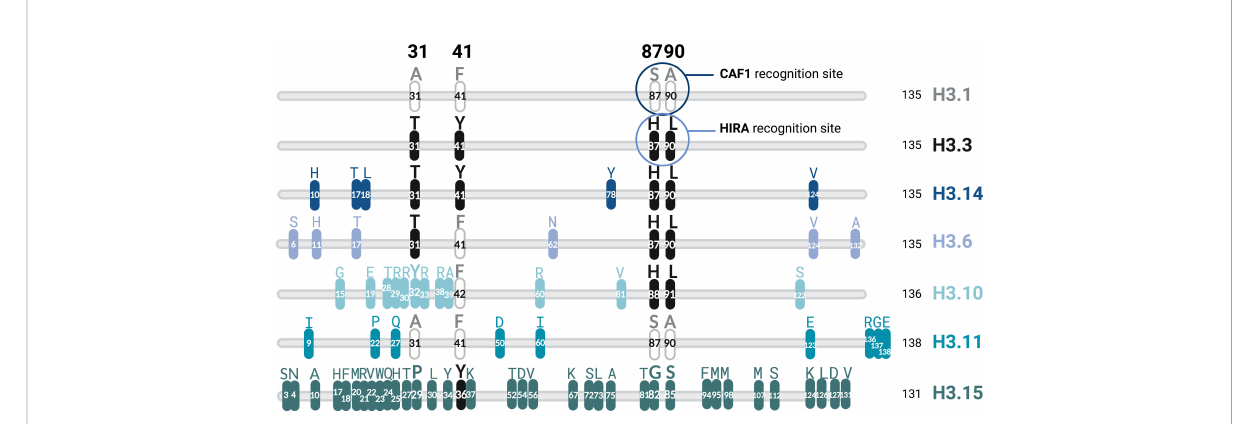
FIGURE 2 Differences in the amino acid sequence of the members of the histone H3 family in Arabidopsis thaliana. The length of each variant ’ s amino acid sequence is indicated in